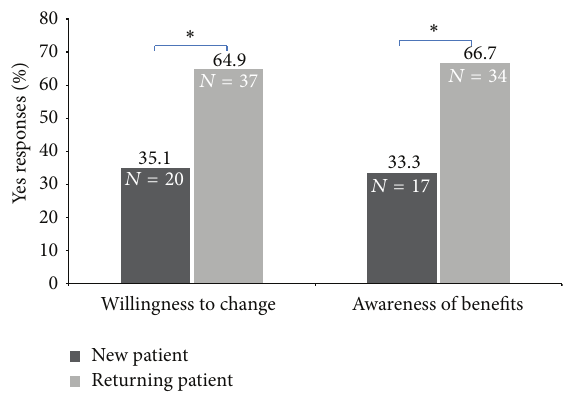
Figure 2: Awareness of the benefits and willingness to try a plant- based diet in new and returning patients. Chi-square analysis comparing new and returning patients; ∗ 𝑃 < 0.05 .